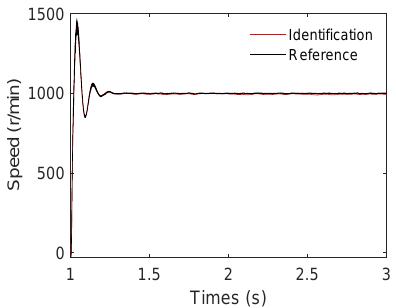
Figure 4. Identification result response curve.